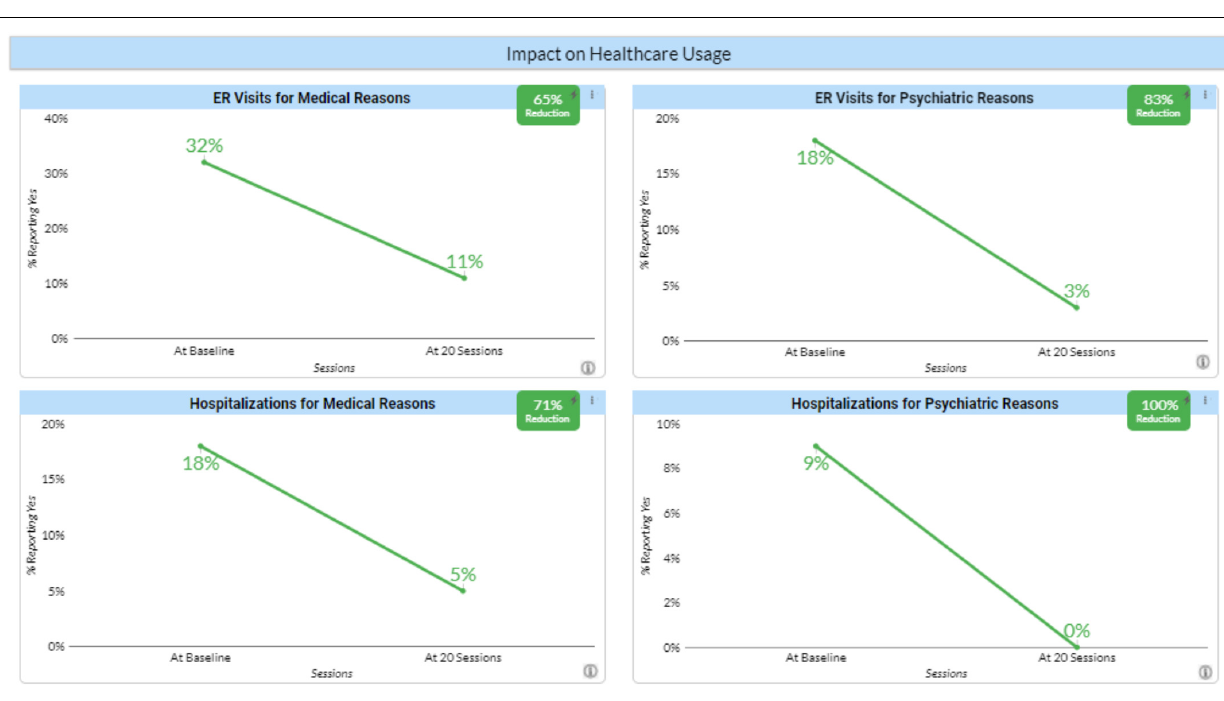
Frontiers in Human Neuroscience |